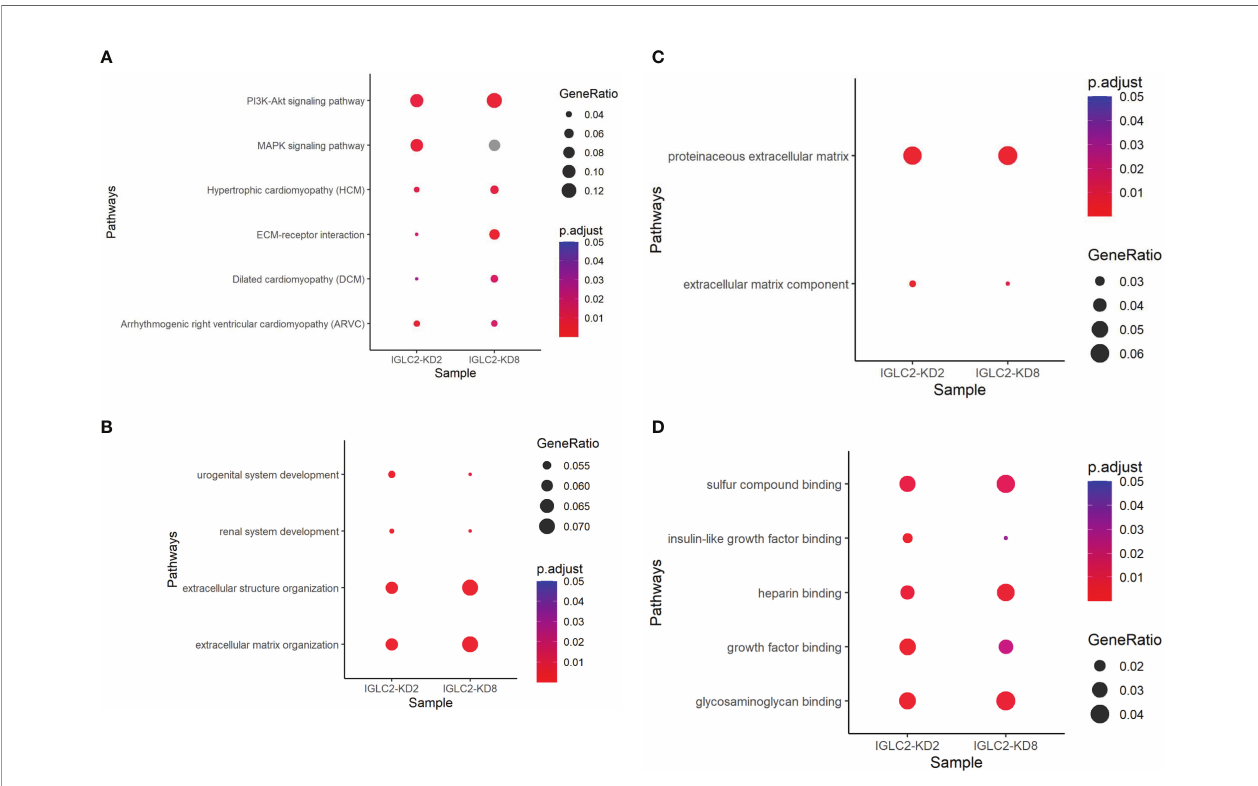
FIGURE 6 | Dot plots of pathway enrichment analysis using annotations of (A) KEGG, (B) GO-BP, (C) GO-CC, and (D) GO-MF. P.adjust means adjusted p value of pathway enrichment analysis. GeneRatio denotes the percentage of target genes existing in the enriched